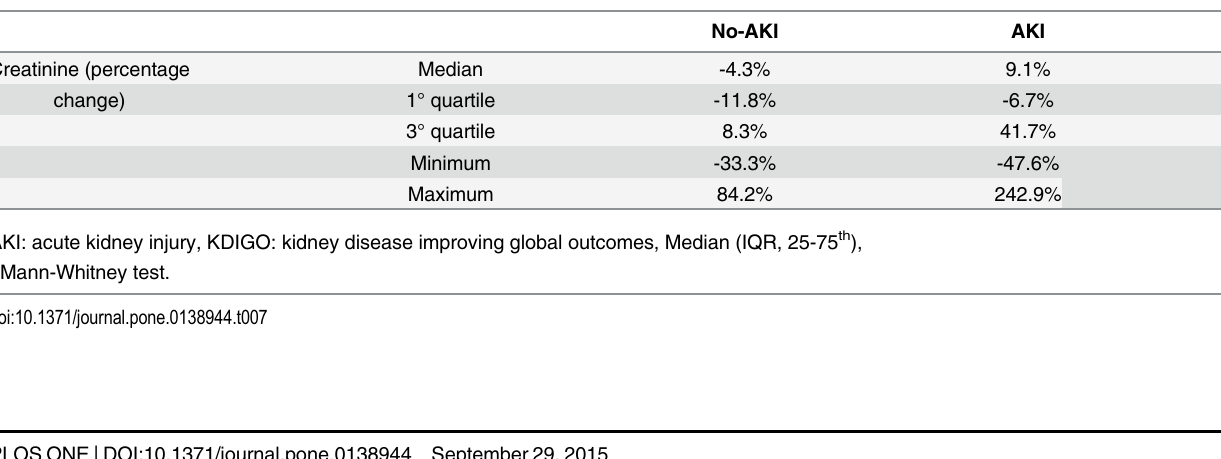
Table 7. Assessment of percentage change from baseline creatinine values to 12 months in patients with and without AKI according to the KDIGO criteria. Creatinine (percentage Median -4.3% 9.1% < 0,001